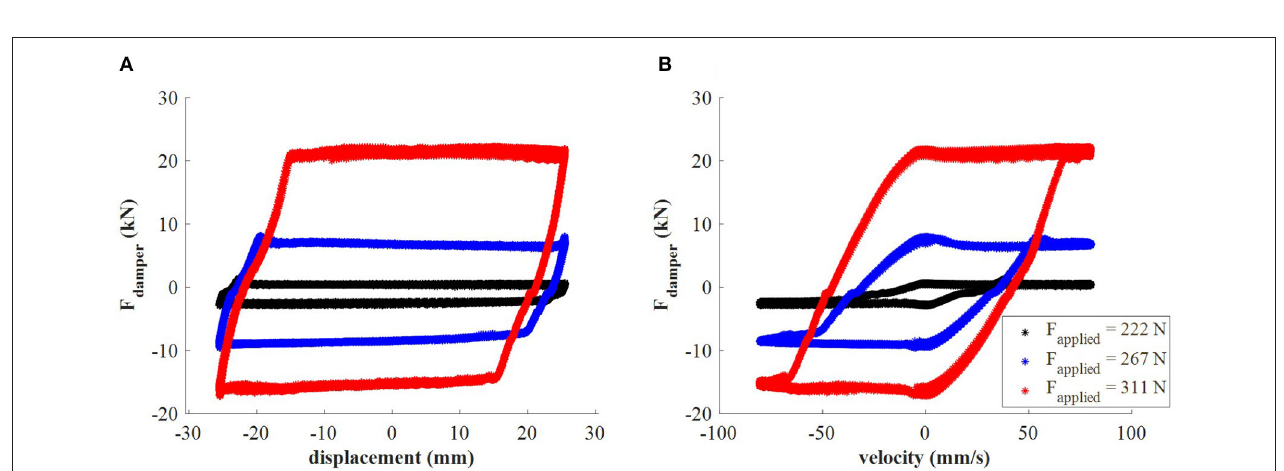
FIGURE 12 | Characterization tests of BRFD under harmonic testing at 0.5 Hz: (A) damper force-displacement response and (B) damper force-velocity response.